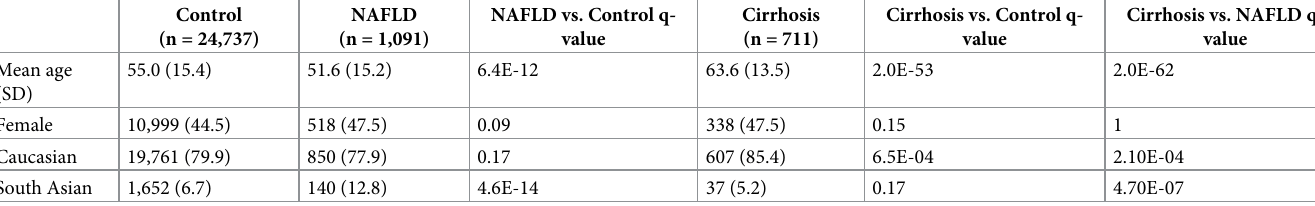
Baseline demographics for participants included in the study. Q-values were derived from chi-squared tests (for sex and ethnicity) or t-tests (for age) with adjustment for multiple testing using the Benjamini-Hochberg method. SD, standard deviation.